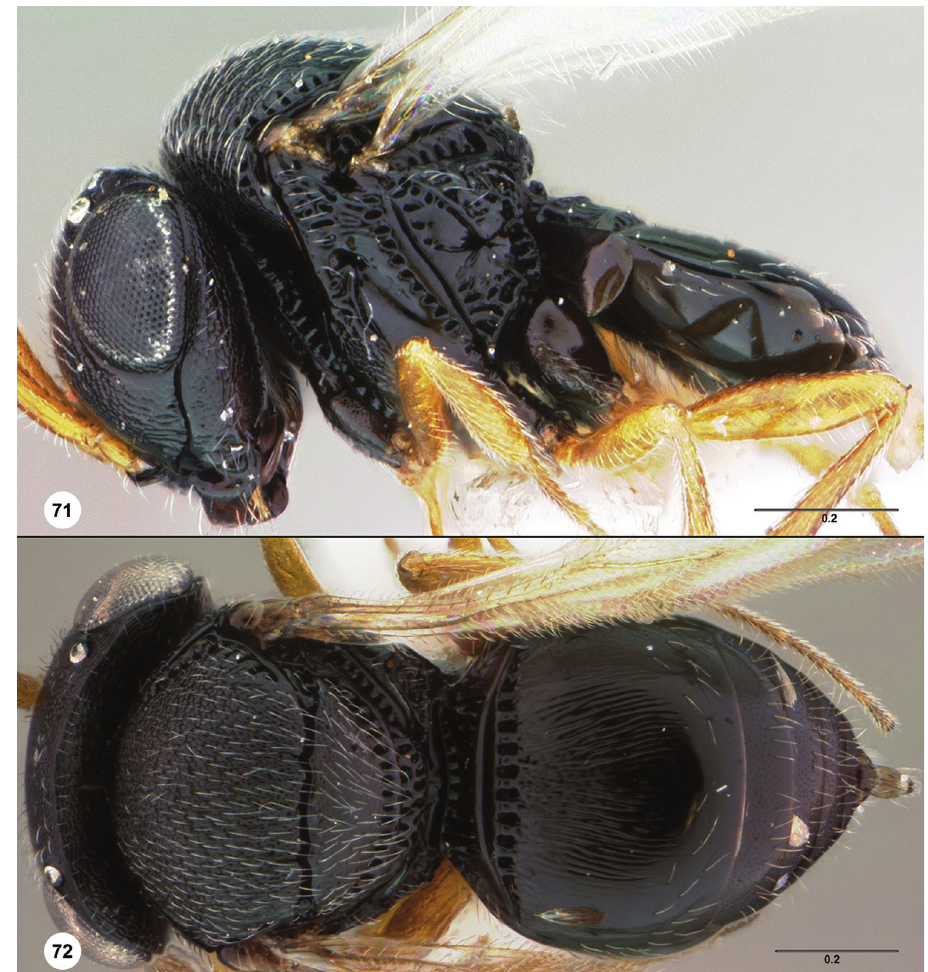
Figures 71–72. Trissolcus gonopsidis 71 male allotype (USNMENT00764938), head, mesosoma, meta- soma, lateral view 72 female (OSUC 542413), head, mesosoma, metasoma, dorsal view. Scale bars in millimeters. coxa. Metapleural epicoxal sulcus: present as coarse rugae. Mesoscutal humeral sulcus: indicated by a line of cells. Median mesoscutal carina: absent. Macrosculpture of mes- oscutum: weakly rugulose posteriorly. Pattern of mesoscutal microsculpture: uniform throughout. Mesoscutal suprahumeral sulcus: comprised of cells. Length of mesoscu- tal suprahumeral sulcus: about half the length of anterolateral edge of mesoscutum. Parapsidal line: present. Notaulus: indicated only at posterior margin of mesoscutum. Median protuberance on anterior margin of mesoscutellum: present. Protruberance on anterior margin of mesoscutellum directly posterior to notaulus: present. Shape of dor- sal margin of anterior lobe of axillar crescent: round. Sculpture of anterior lobe of